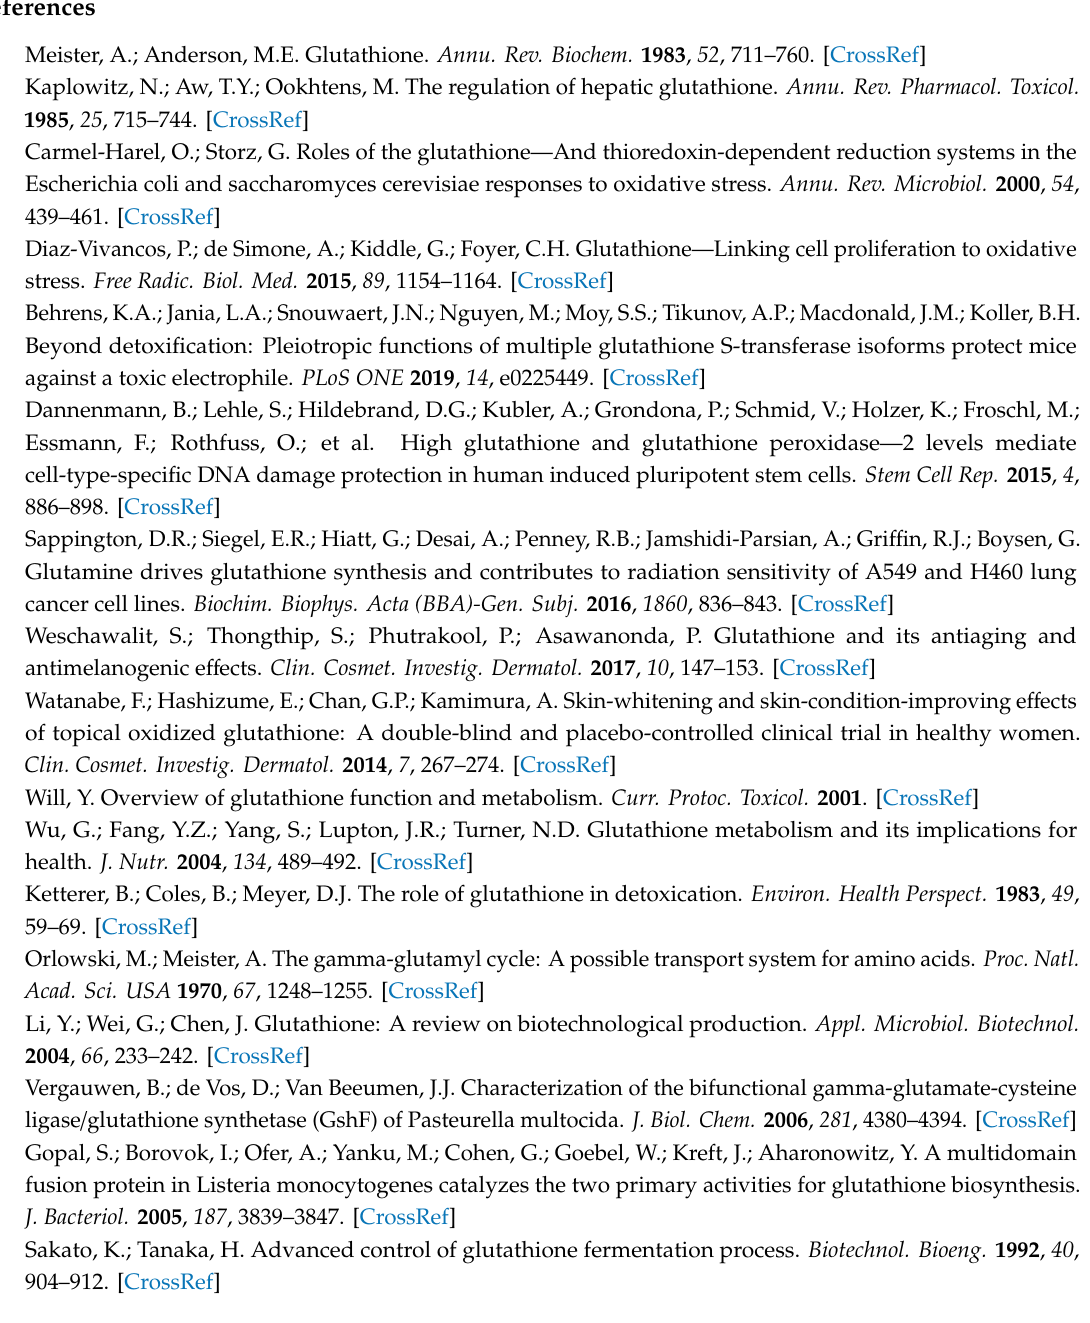
Figure S1: The e ff ect of the first-step reaction time on glutathione